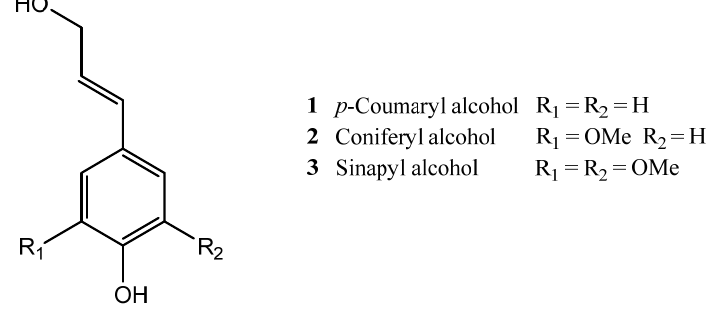
Figure 2. The three phenylpropanoid building blocks of lignin.